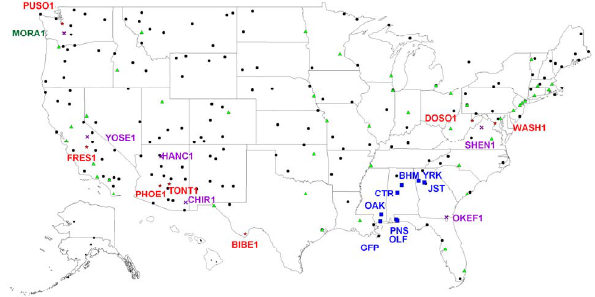
Figure 1. Fig. 1. Sampling locations for the 181 Interagency Monitoring of Protected Visual Environments (IMPROVE) sites (circles, mostly non-urban), 239 Speciation Trends Network (STN)/Chemical Speciation Network (CSN) sites (triangles, mostly urban), and eight paired Southeastern Aerosol Research and Characterization study (SEARCH) sites (squares, urban vs. non-urban/suburban pairs [Mississippi GLF (urban Gulfport) and OAK (non-urban Oak Grove near Hattiesburg); Alabama BHM (urban north Birmingham) and CTR (non-urban Centreville, south of Tuscaloosa); Georgia JST (urban Jefferson Street in Atlanta) and YRK (non-urban Yorkville, west northwest of Atlanta); and Florida PNS (urban Pensacola) and OLF (suburban outlying field northwest of Pensacola, classified as non-urban)]). The six IMPROVE locations that include quartz- fiber behind quartz-fiber filters (QBQ) are indicated by purple crosses (Mount Rainier National Park, WA [MORA1]; Yosemite National Park, CA [YOSE1]; Hance Camp, Grand Canyon National Park, AZ [HANC1]; Chiricahua National Monument, AZ [CHIR1]; Okefenokee National Wildlife Reserve, GA [OKEF1]; and Shenandoah National Park, WV [SHEN1]). The eight collocated IMPROVE/CSN sites are indicated by red stars (Puget Sound, WA [PUGO1]; Mount Rainier National Park, WA [MORA1]; Fresno, CA [FRES1]; Phoenix, AZ [PHOE1]; Tonto National Monument, AZ [TONT1]; Big Bend National Park [BIBE1]; Dolly Sods Wilderness [DOSO1]; and Washington DC [WASH1]). MORA1 (Mount Rainier, WA), which is included both in the IMPROVE QBQ and the collocated IMPROVE/CSN sites, is indicated in dark